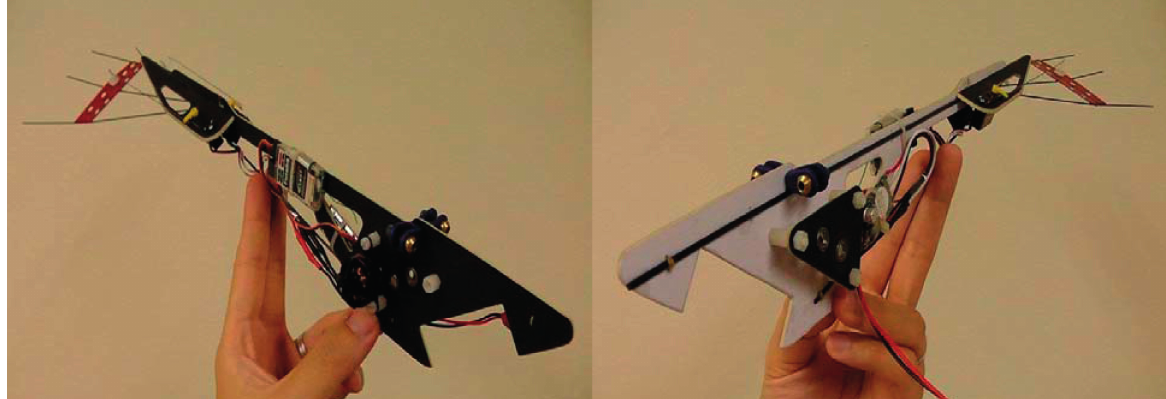
Figure 14. Overall view of entire flapping mechanism.